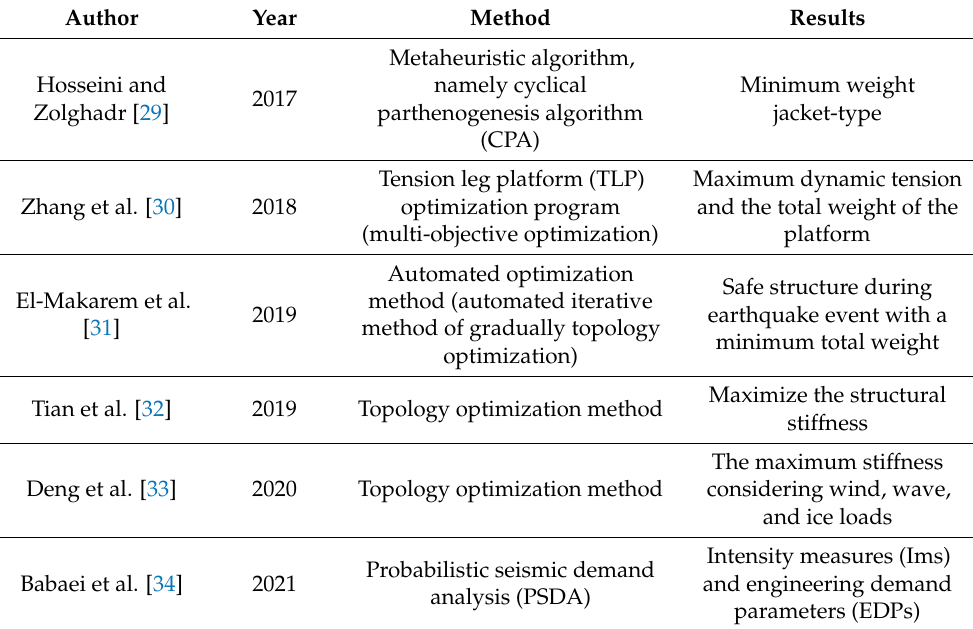
Table 1. The summary of various novel optimization methods used for offshore